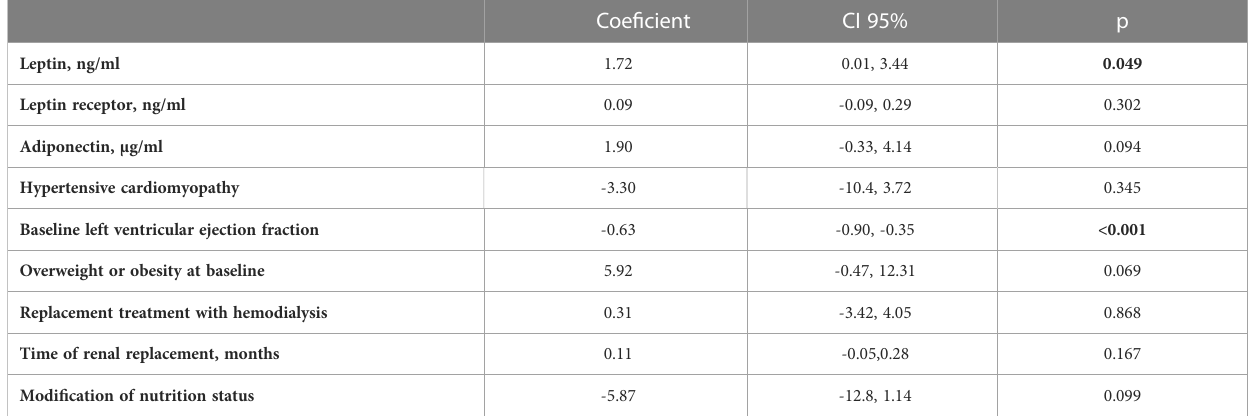
TABLE 3B Linear regression analysis to identify the association of leptin and leptin receptor with delta-left ventricular ejection fraction at 24-month follow-up in in CPK pediatric patients